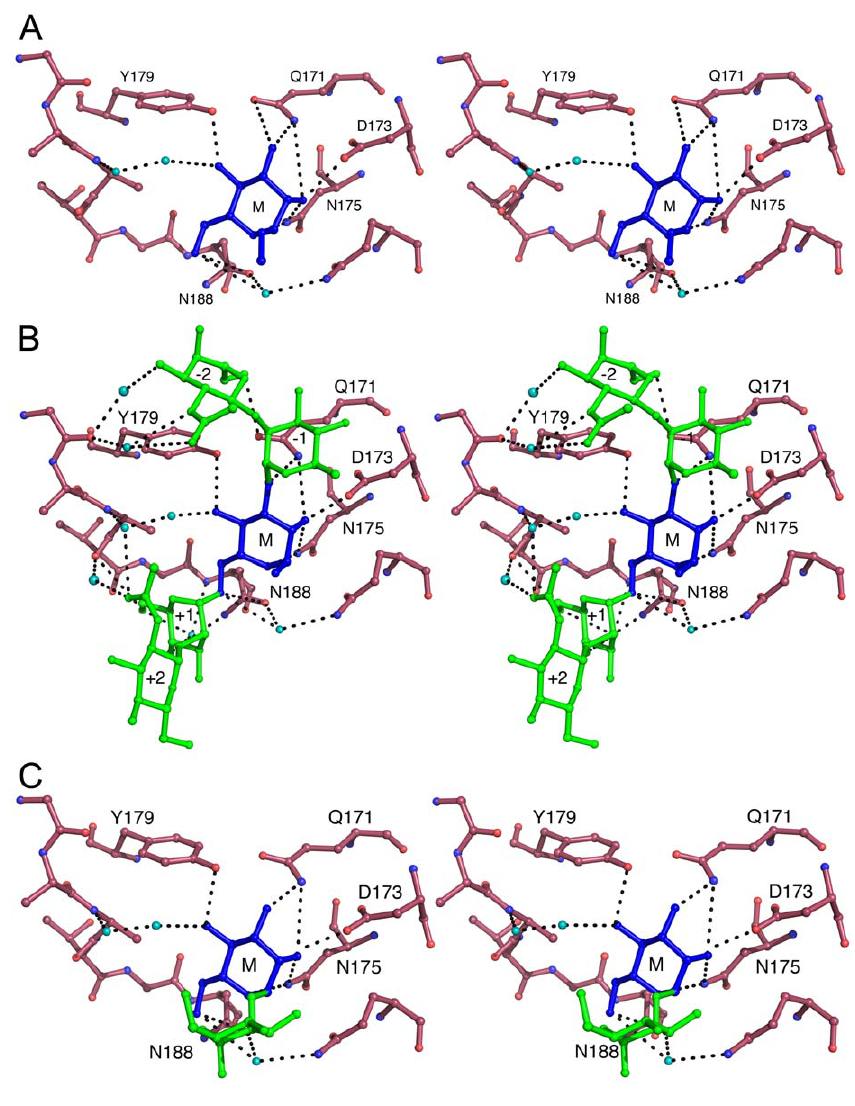
Figure 3. Carbohydrate binding in site III C of LlpA BW . (A) Stereoview of methyl- a -D-mannopyranoside bound to subdomain III C . Methyl- a -D- mannopyranoside is shown in blue and indicated by M. Residues belonging to the QxDxNxVxY motif and hydrogen bonding to the sugar as well as Asn188 are labeled. Water molecules bridging protein and carbohydrate are shown in cyan (B) Similar view of the pentasaccharide GlcNAc b (1– 2)Man a (1–3)[GlcNAc b (1–2)Man a (1–6)]Man. The mannose residue occupying the primary binding site is shown in blue and labeled M. The additional two mannoses (labeled + 1 and 2 1) and two N -acetyl glucosamine residues (labeled + 2 and 2 2) are shown in green. Other colors are as in panel A. (C) Binding of the disaccharide Man a (1–2)Man. The non-reducing mannose residue occupying the primary binding site is shown in blue and labeled M. The second, reducing mannose is shown in green. Other colors are as in panel A.